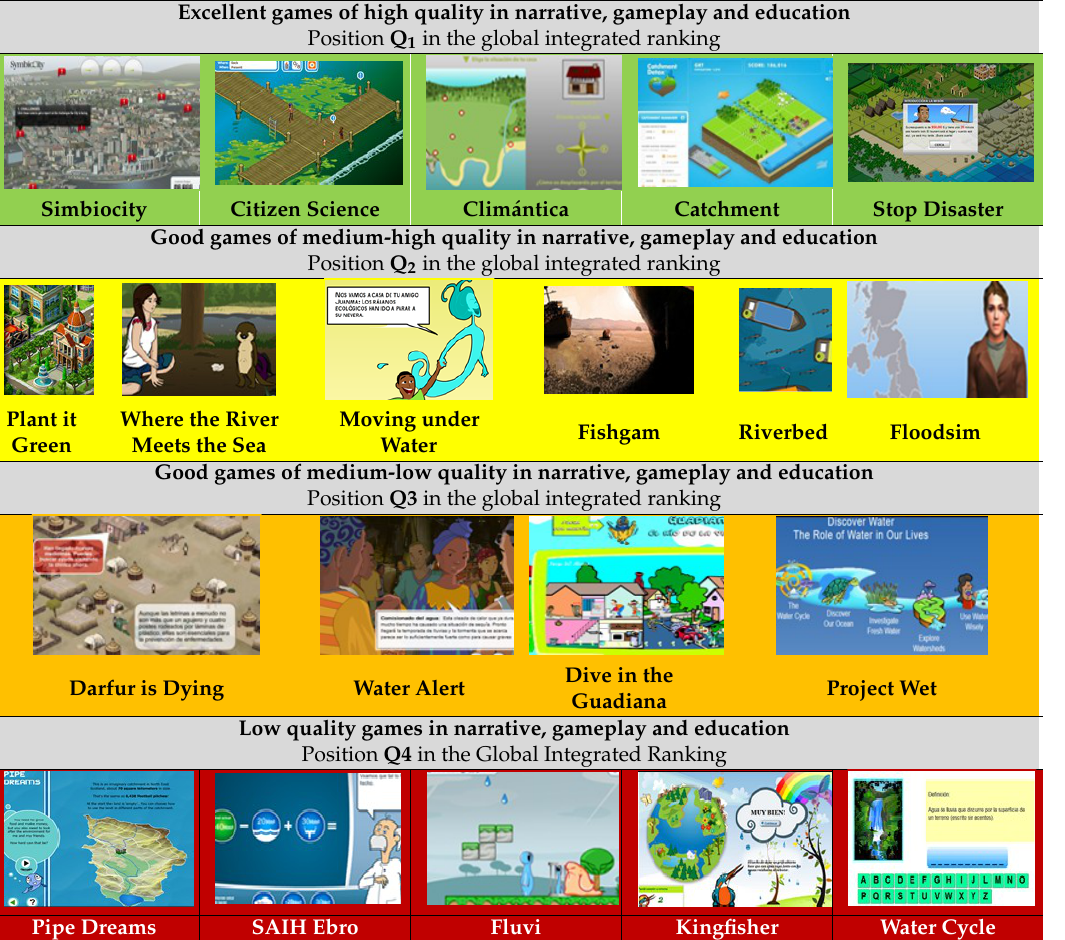
Table 4. Global integrated ranking of video games about water according to quantitative evaluation of experts: game classification and position by quartile.